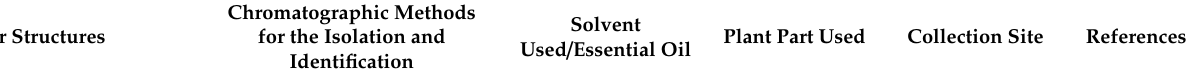
Table 3. Phytochemical analysis of G. americana.